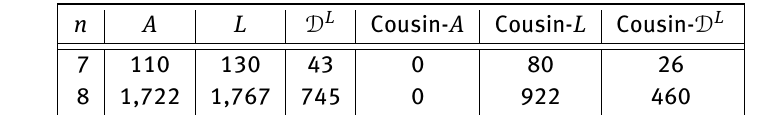
Table 1: A table of all graph with a cospectral mate for their respective matrices and graphs whose cospectral mate is found by a cousin cospectral